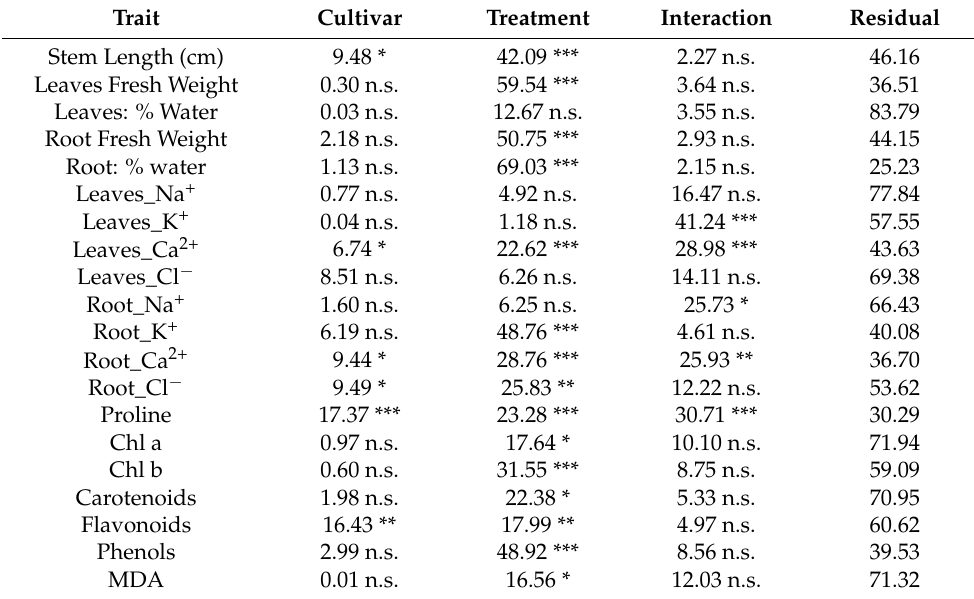
Table 2. Two-way analysis of variance (ANOVA) testing the effect of cultivar and treatment (percent- age interval of humidity) and their interactions for all morphological and biochemical traits analysed. Numbers represent F values. Asterisks indicate the degree of significance: * p < 0.05, ** p < 0.01; *** p < 0.001, n.s. = not